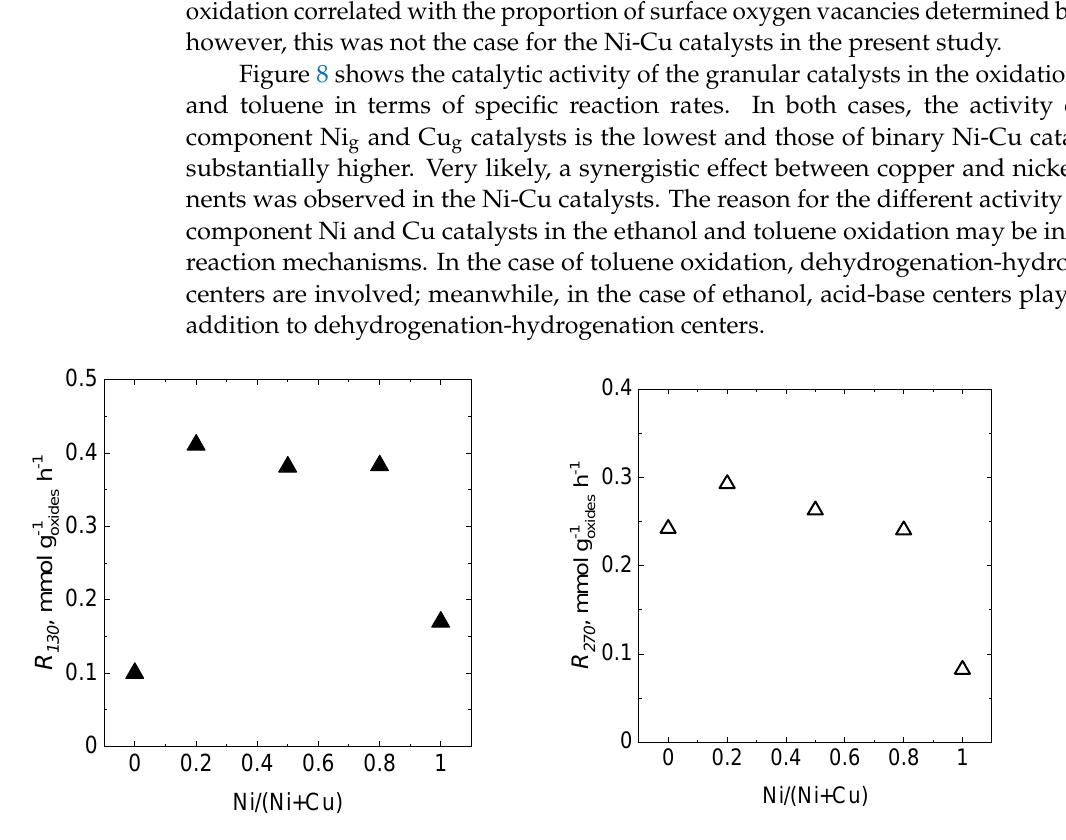
Figure 8. Catalytic activity of granular catalysts expressed as specific reaction rate R 130 in the oxidation of ethanol ( left ), and specific reaction rate R 270 in the oxidation of toluene ( right ) in dependence on Ni/(Ni + Cu) molar ratio.